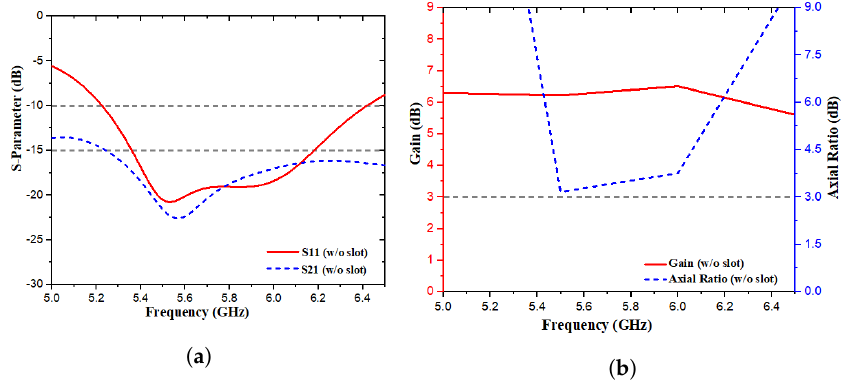
Figure 3. ( a ) S11/S22 of MIMO antenna without a ground slot. ( b ) Gain and AR of the MIMO antenna without a ground slot.